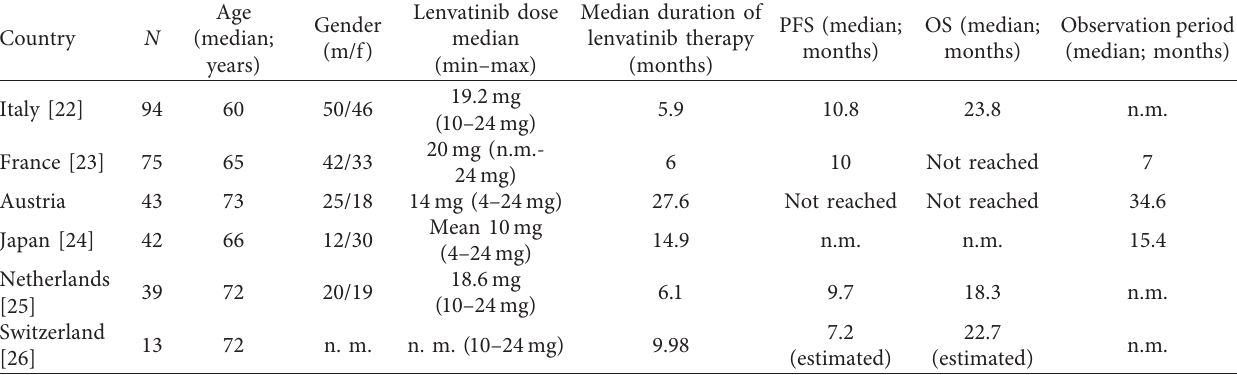
Table 4: Real-life studies from Europe and